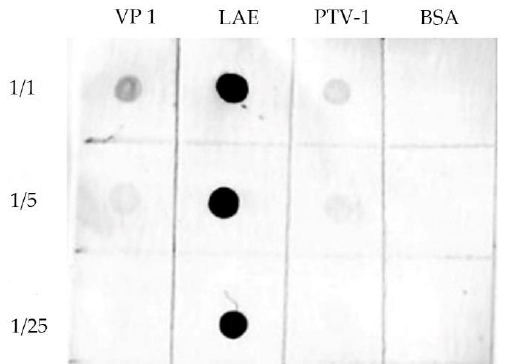
Figure 5. Assessment of the reactivity of the antiserum against LAE3 (LAE), and whole virions of PTV-1 PS34 (PTV-1) and rVP1 protein of PTV-1 PS34 (VP1) by dot blotting. BSA of similar concentrations started at 100 ng/µL served as an unrelated protein control.